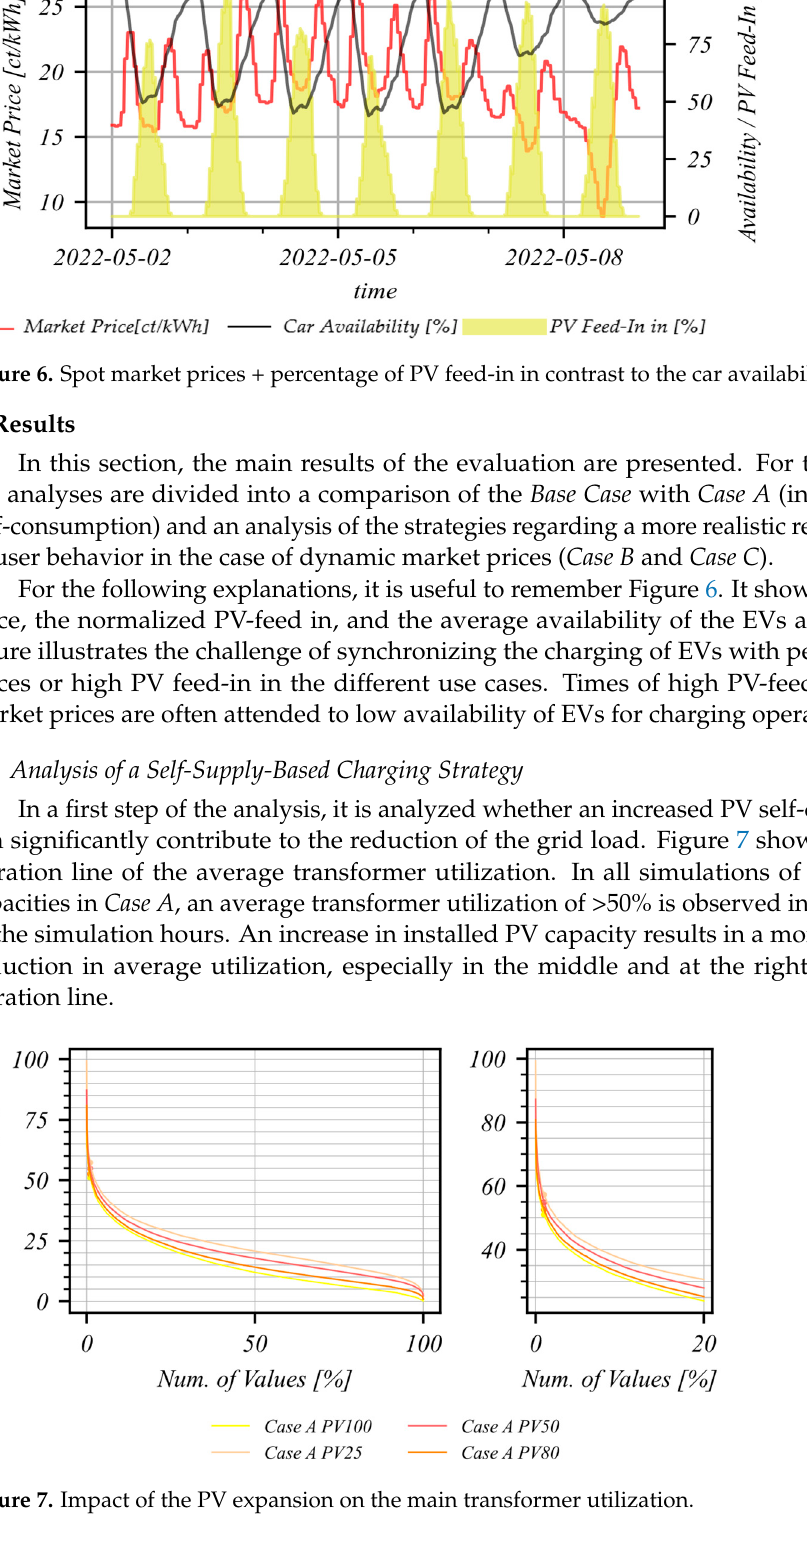
Figure 5. Exemplary resulting charging curves of the same EV visualized for the Base Case , Case A , Case B , and Case C with 80% installed PV potential on buildings in the simulation.